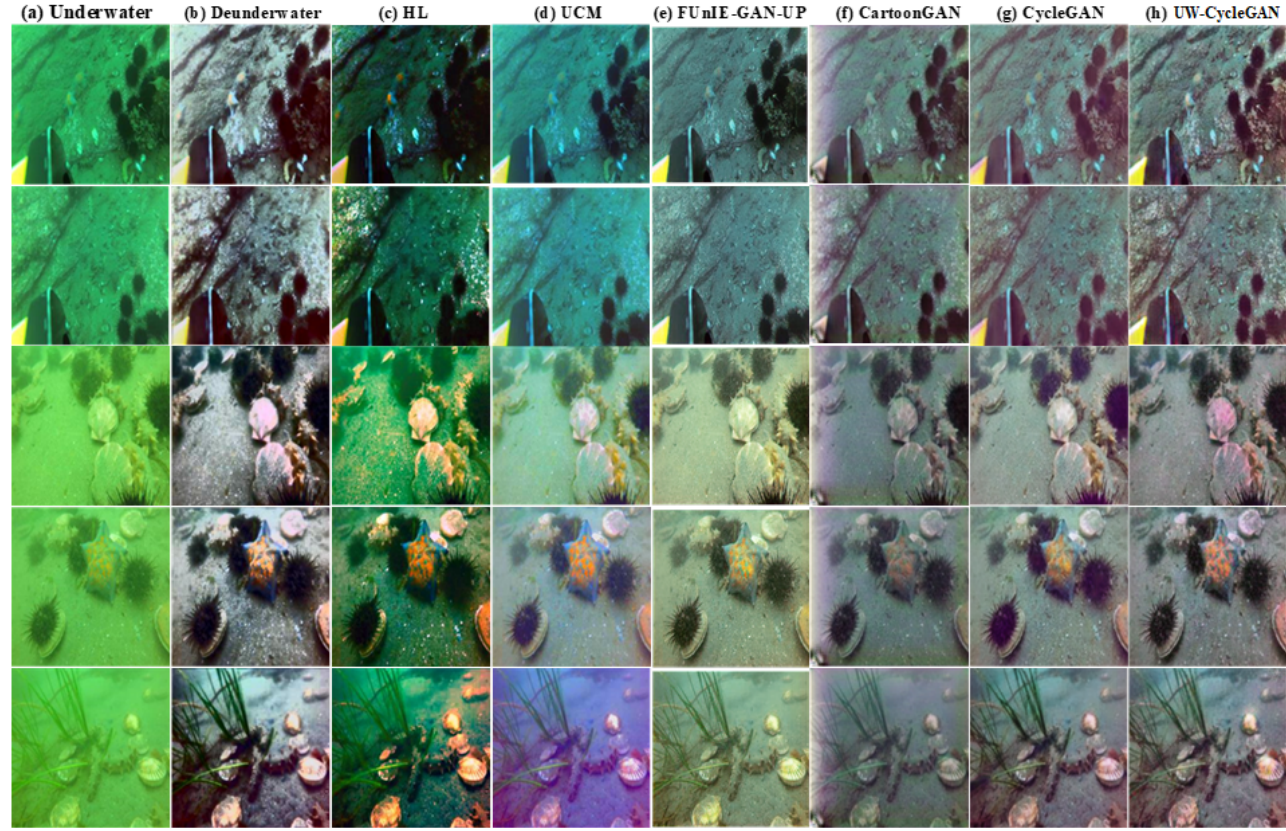
Figure 5. Visual quality comparisons of the enhanced underwater images on the URPC dataset.